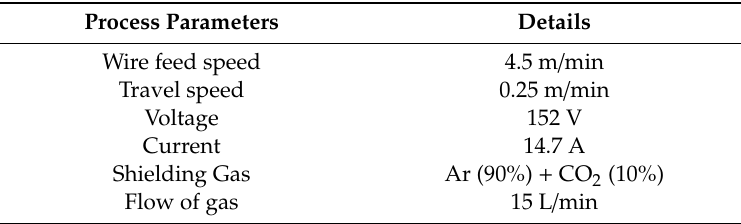
Table 2. Process parameters for deposition.